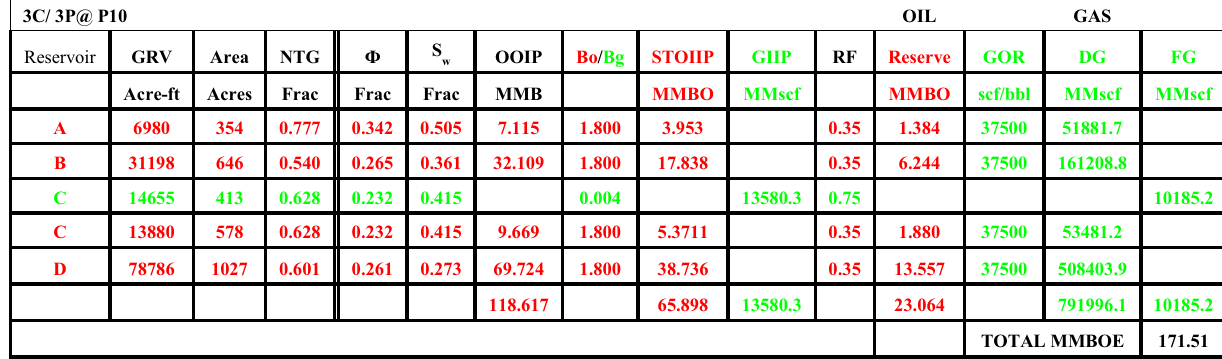
Table 4 Proven Reserve Resources Estimate at 3-P/P10 for ROI